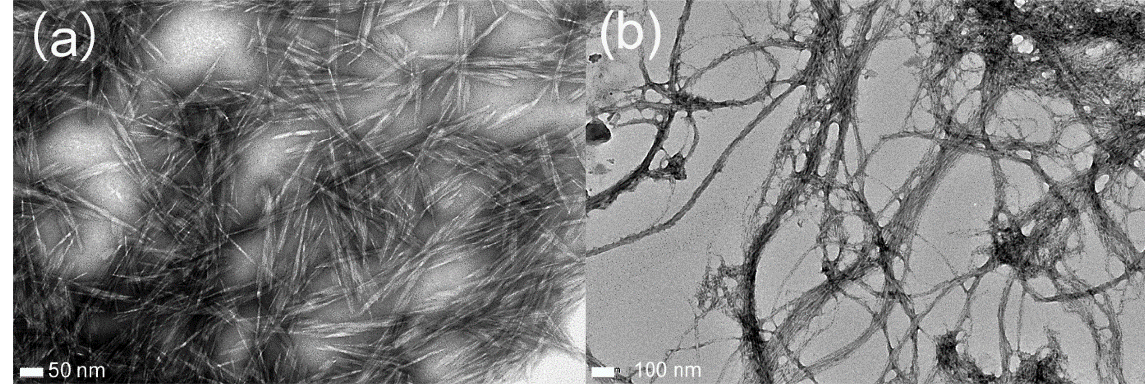
Figure 2: TEM images of (a): CNC and (b): NFC. Image reproduced from [32]. Copyright 2013 American Chemical Society.